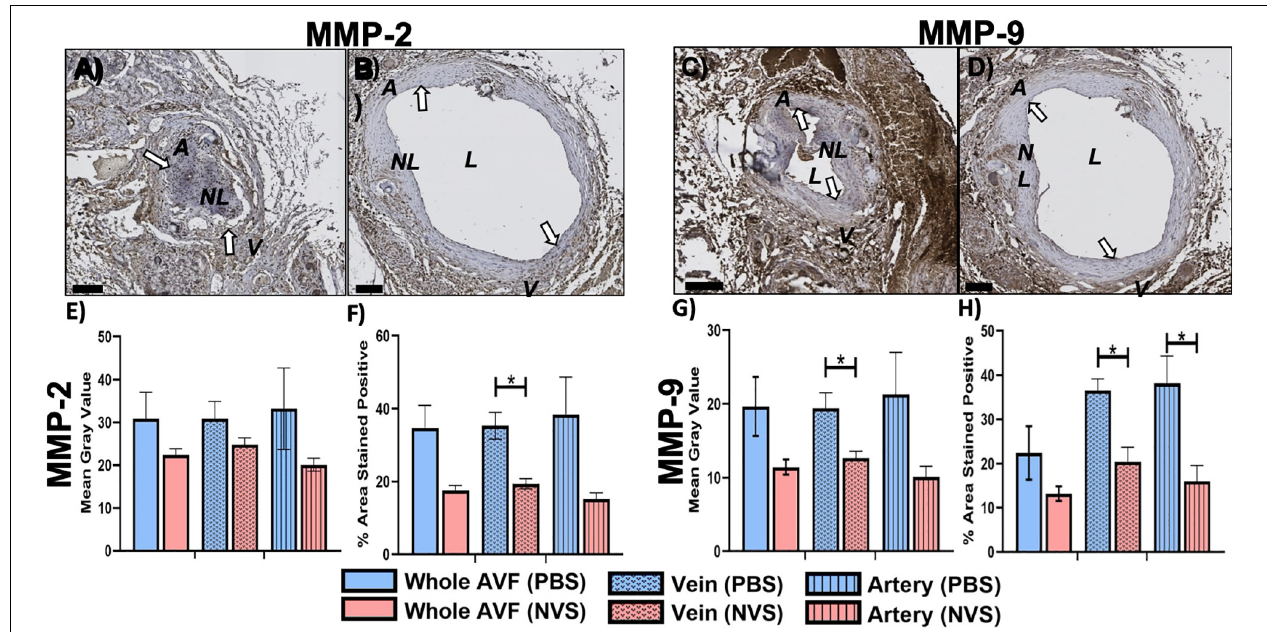
FIGURE 3 | MMP analysis. Representative immunohistochemistry images of MMP-2 (A,B) and MMP-9 (C,D) staining of the AVF anastomoses at 4 weeks from animals treated with PBS (A,C) and NVS (B,D) . (E,G) Quantification of staining intensity (i.e., mean gray value). (F,H) Quantification of the percent area stained positive. Analyses were performed for the whole AVF, venous limb, and arterial limb. Results are presented as average ± standard error of mean. White arrows indicate example regions of positive staining. N = 3 per group. * p < 0.05. Scale bar = 100 µ m. A, arterial limb of AVF; V, venous limb of AVF; L, lumen; NL, neointimal